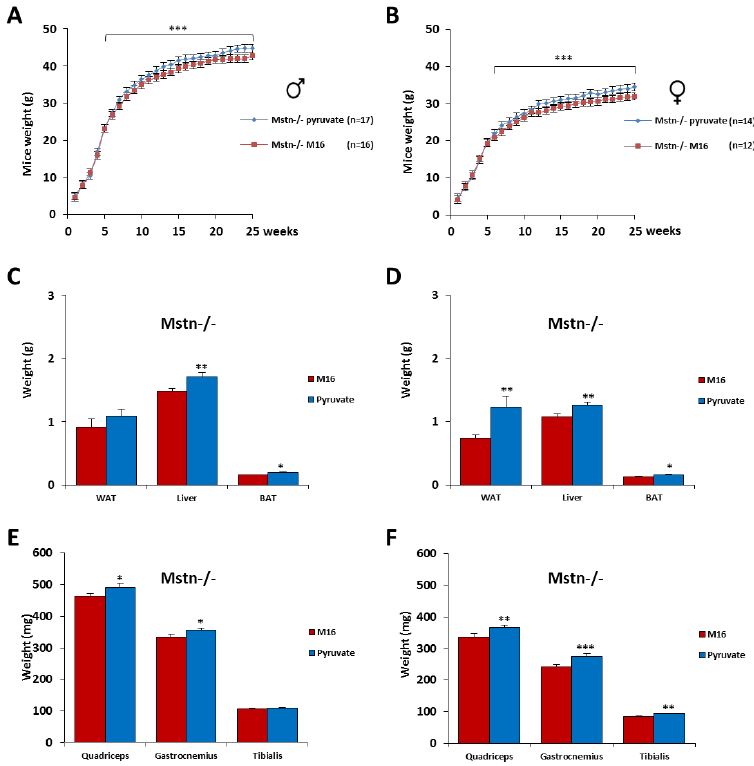
Figure 5. Skeletal muscle hypertrophy was increased in myostatin deficient (Mstn−/−) mice of both genders by a short exposure in M16/pyruvate medium at 1 cell embryo stage. Post-natal growth profiles of male ( A ) and female ( B ) Mstn−/− mice derived from zygotes incubated in M16 or M16/pyruvate media. At 6 months of age, the mice were sacrificed, and WAT, BAT, and liver were weighed ( C ): male; ( D ): female, as well as the skeletal muscles (quadriceps, gastrocnemius, and tibialis) ( E ): male; ( F ): female. For male Mstn−/− mice, n = 17 in M16 medium and 16 in M16/pyruvate medium. For female Mstn−/− mice, n = 14 in M16 medium and 12 in M16/pyruvate medium. Statistical significance: * p < 0.05, ** p < 0.01, *** p < 0.001, Student’s t -test. Results are expressed as ± sem.